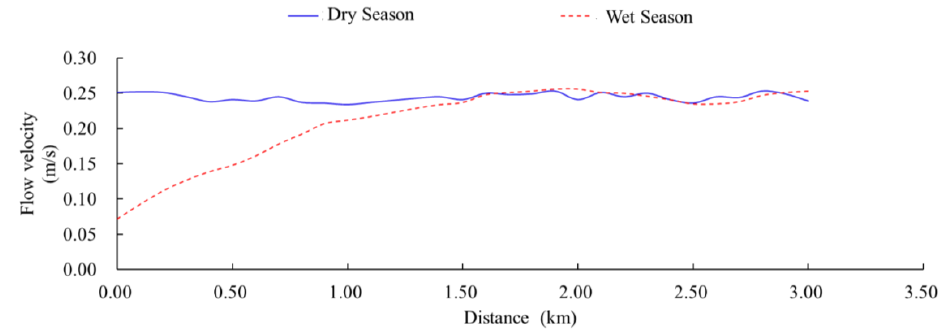
Figure 9. Flow velocities along the Baigou Canal during the dry (April) seasons and wet (August) as a function of distance from the lake’s inlet.